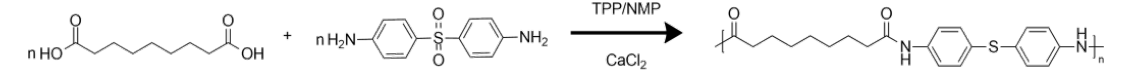
Figure 6. Polyamide synthesis from AzA and 4,4 ′ -diamino diphenyl sulfone. TPP — triphenyl phos- phite, NMP — N-methyl-2-pyrrolidone.